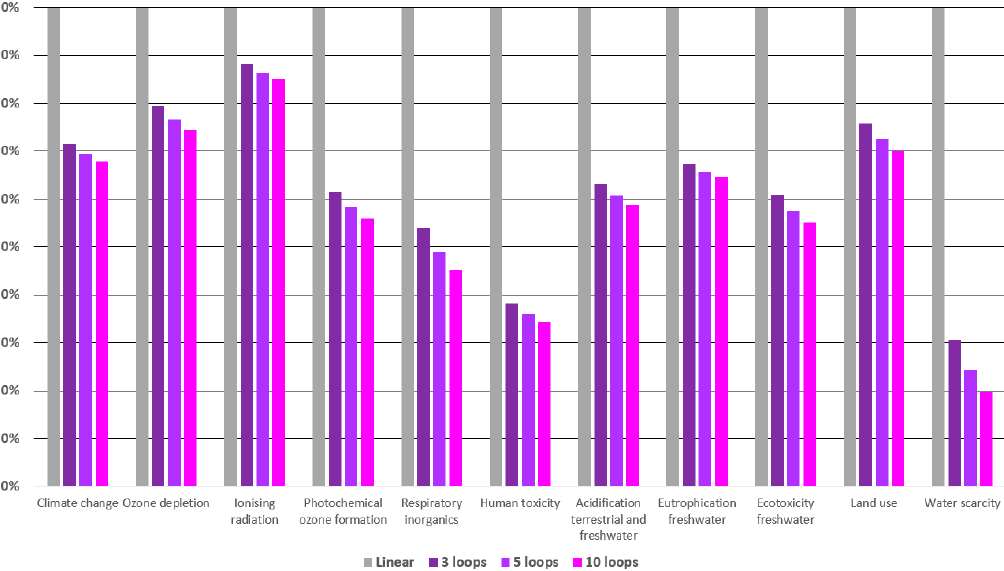
Figure 4. Environmental impact comparison between one linear product system and the average impacts of three, five and ten wear2wear TM product systems. Each of the product systems contain one first (blue) loop. The remaining product systems are second (orange) loops.